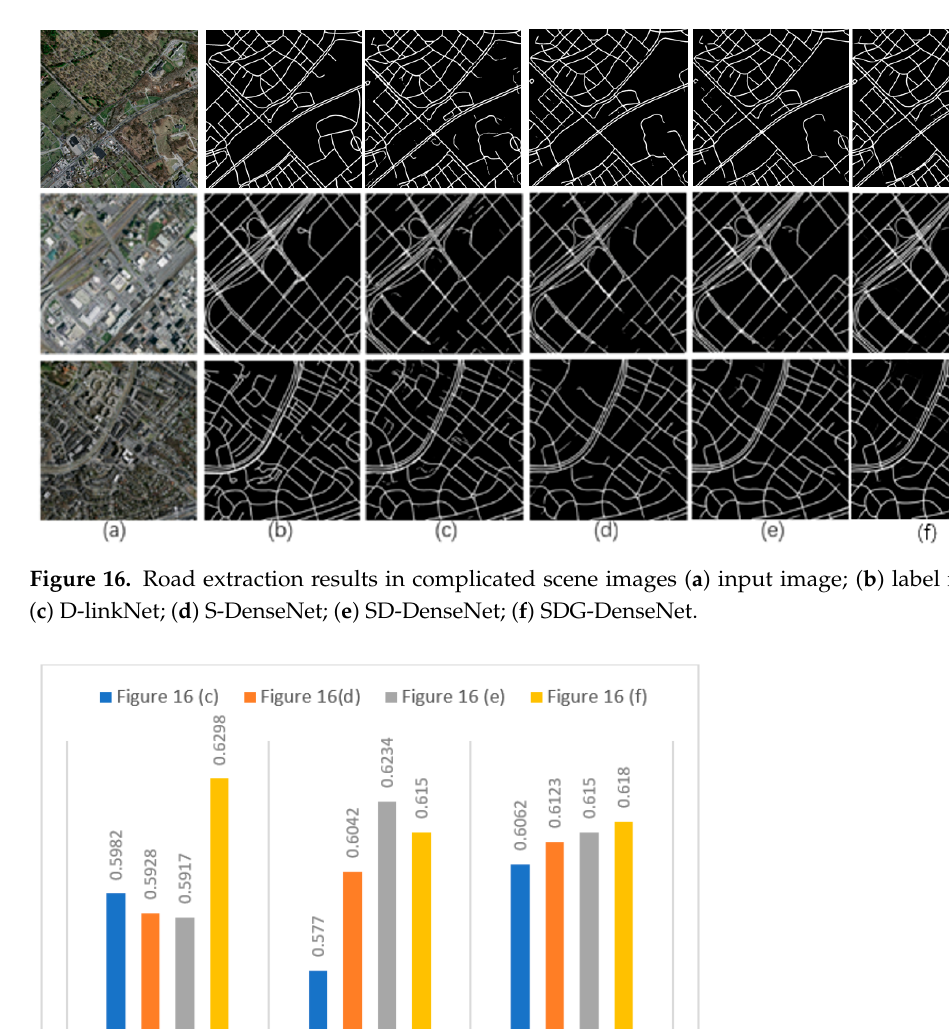
Figure 15. IoU scores of the methods in Figure 14.